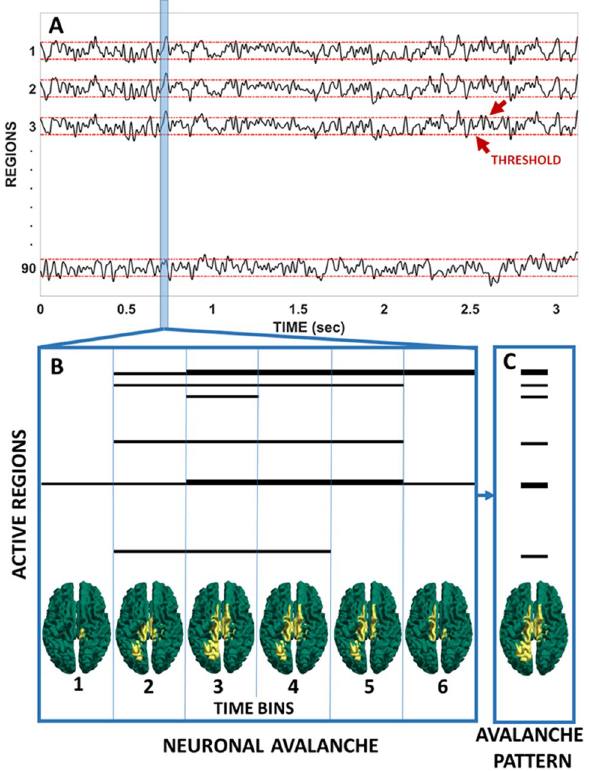
Figure 1. Schematic representation of an avalanche pattern. ( A ) Reconstructed time series (z-scores). The red dashed lines indicate the threshold to define activation. ( B ) An avalanche is a sequence of activations that starts when one or more regions are above threshold and ends when no region is above threshold anymore. The brains-plots for each moment (bin) of the avalanche show the areas above (yellow) and below (green) threshold ( C ). The areas that were above threshold at some time during the avalanche together form the avalanche pattern. The figure was done using MatlabR2019a and Inkscape